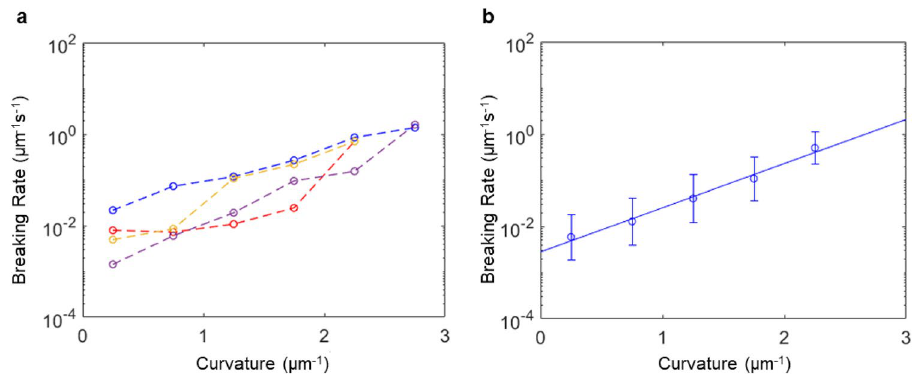
Figure 5. Breaking rate as a function of local curvature. ( a ) The 4 individual experiments with 1 mM ATP, 500 μm −2 kinesin. ( b ) The combination of the four experiments. The circles are estimated using the Bayesian formula described in Eq. (3); the solid line is fit using maximum likelihood